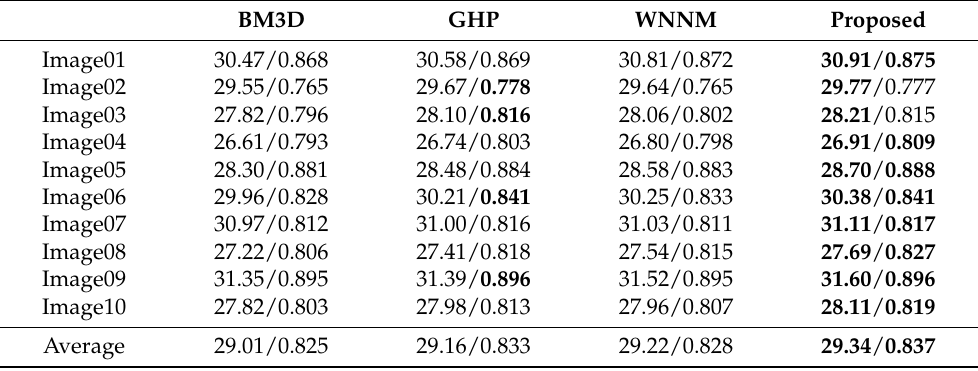
Table 2. The PSNR [dB] and SSIM results obtained after denoising on dataset I (with a noise standard deviation of 𝜎 =